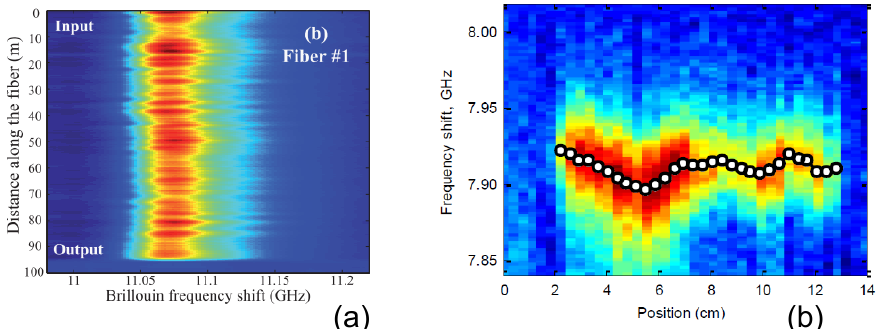
Figure 9. Longitudinal map of ( a ) a PCF using Brillouin echo distributed sensing (BEDS) techniques with a spatial resolution of 30cm [38] (reprinted with permission from [38], OSA) and ( b ) a microfibre based on phase-coded BOCDA [100] (reprinted with permission from [100], OSA).